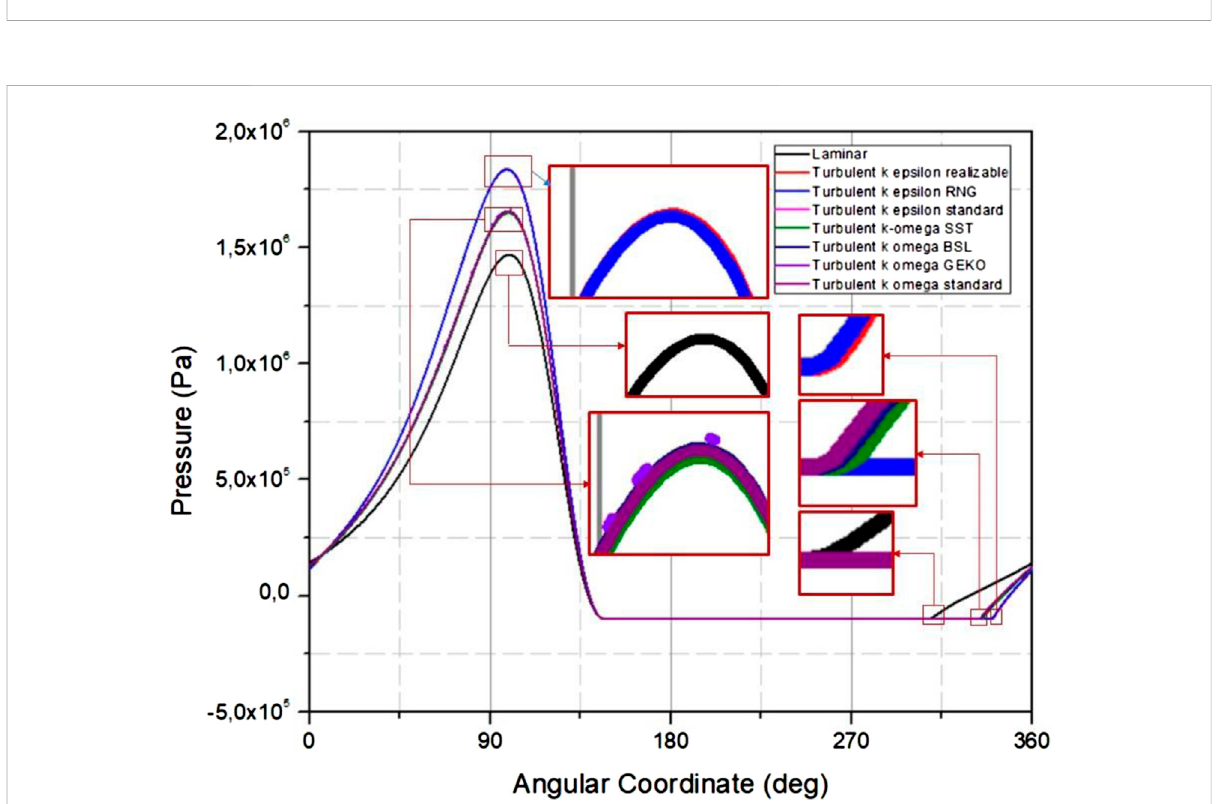
FIGURE 5 Plot of pressure at the midplane smooth journal bearing, ε = 0.7 dan ω = 3,000